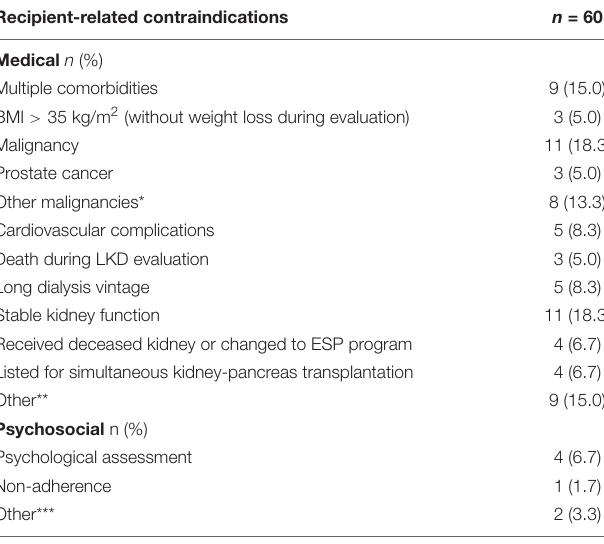
TABLE 6 | Recipient-related reasons for disqualification from LKD